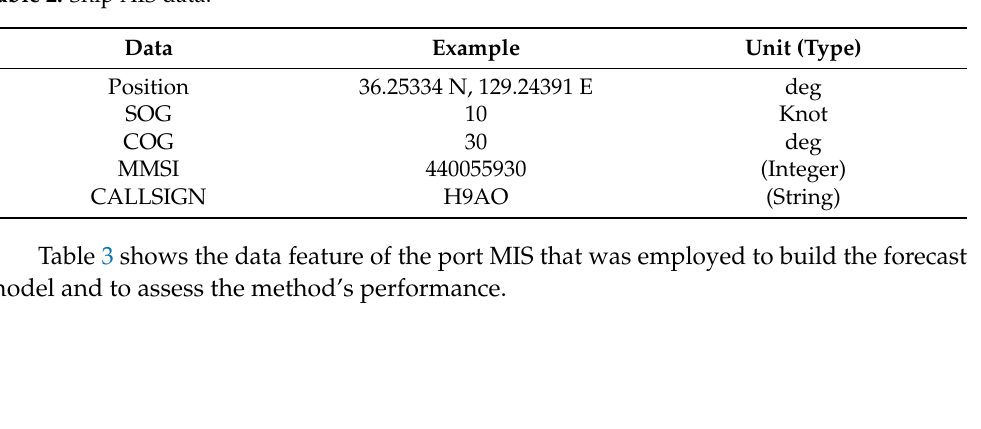
Table 2. Ship AIS